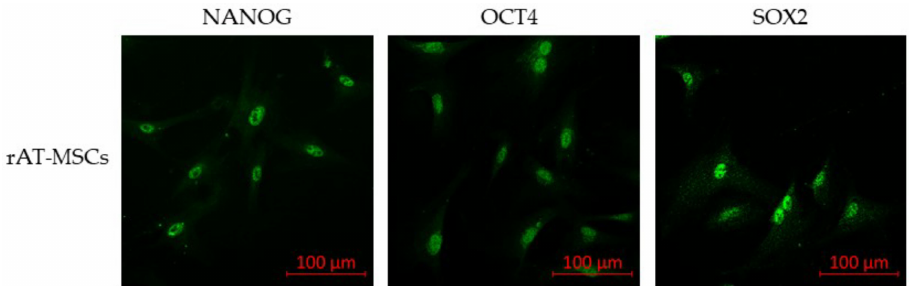
Figure 3. Immunofluorescence of selected intracellular markers of rabbit (rAT-MSCs) and human (hAT-MSCs) samples; α -SMA— α smooth muscle actin; (scale bar = 100 µ m).